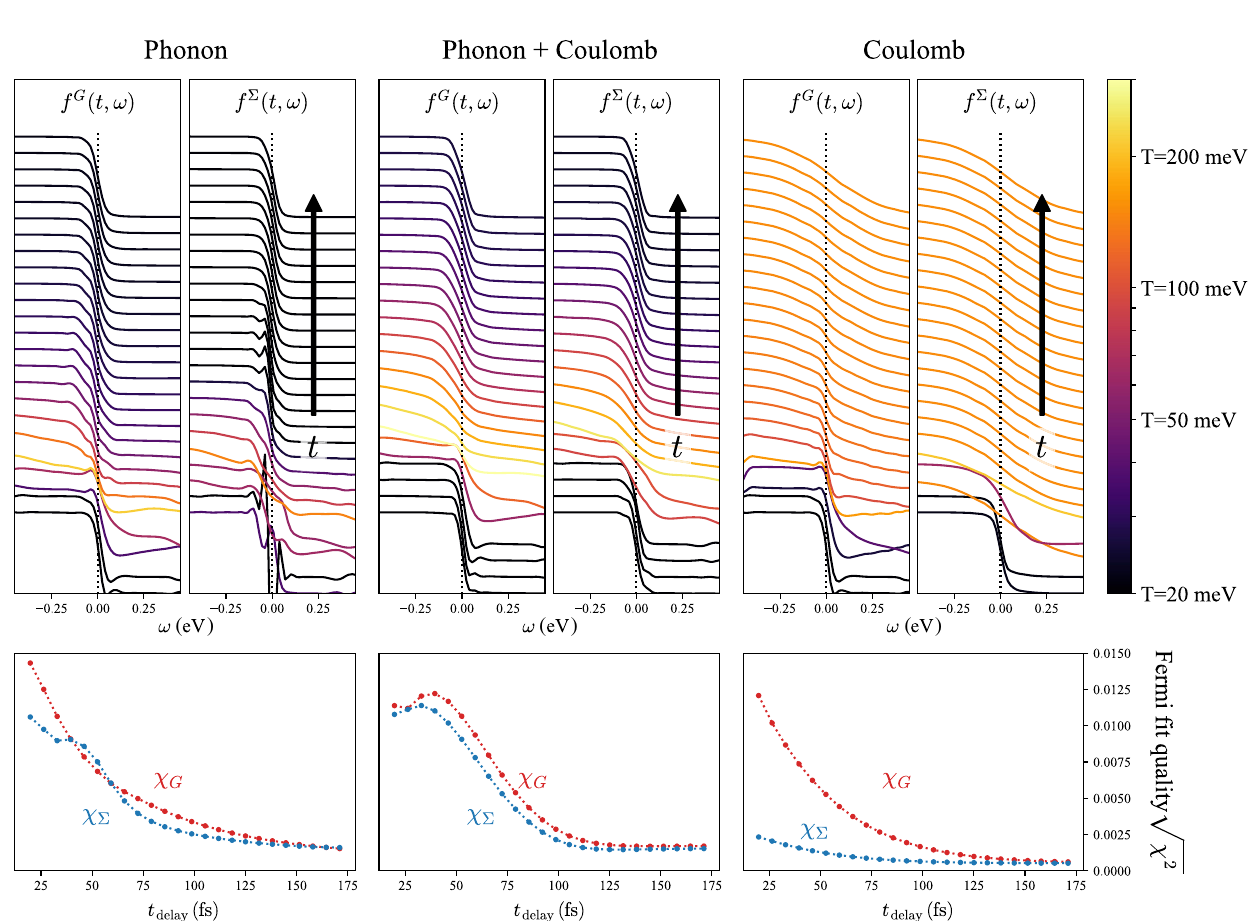
and f Σ ð ω ; t for three of the cases considered. The line p ffiffiffiffiffi ave Þ ave Þ χ 2 corresponding to the Fermi function fits for the three